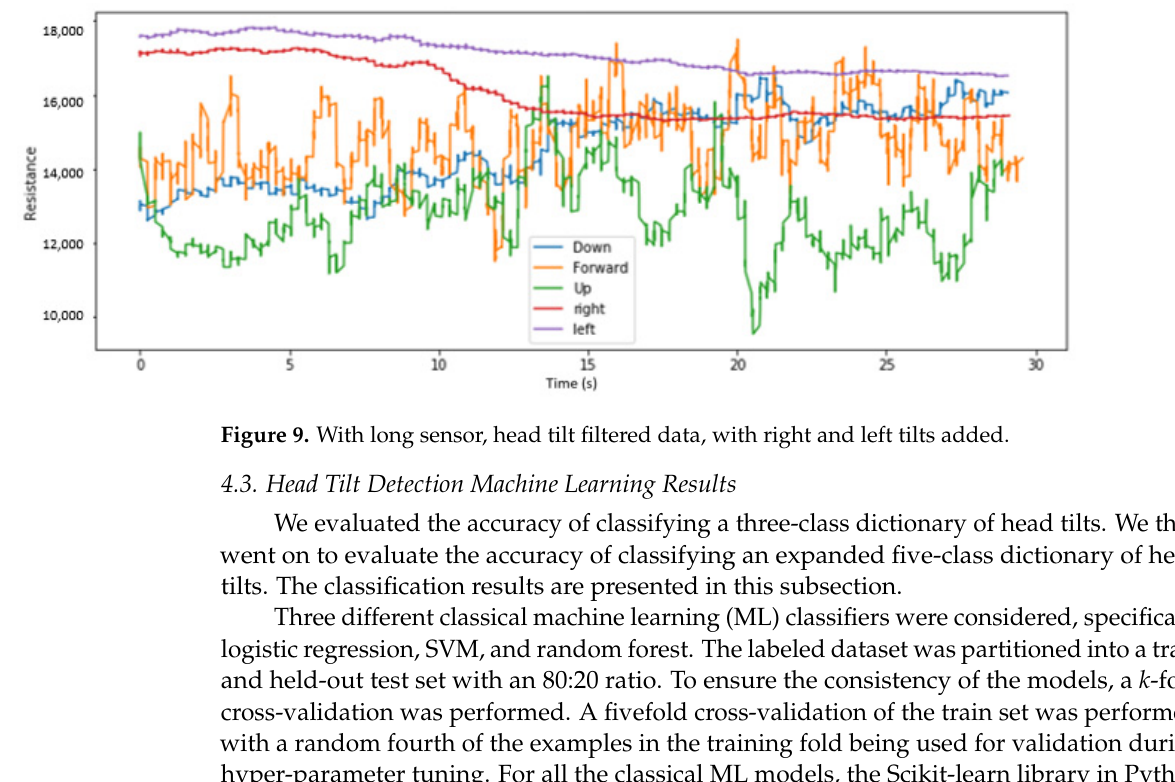
Figure 8. With low placement of short sensor, head tilt filtered data, with right and left tilts added.